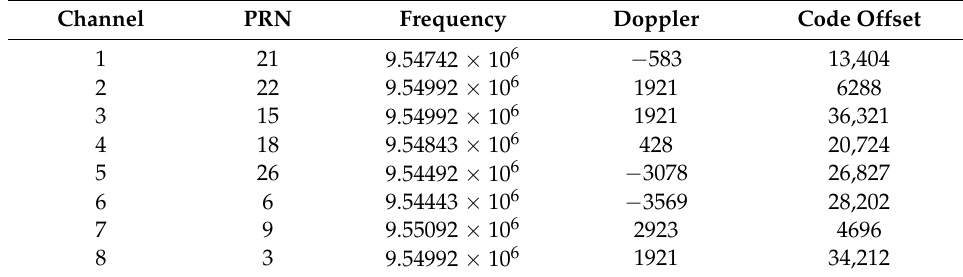
Table 2. PRNs of Dataset 1.